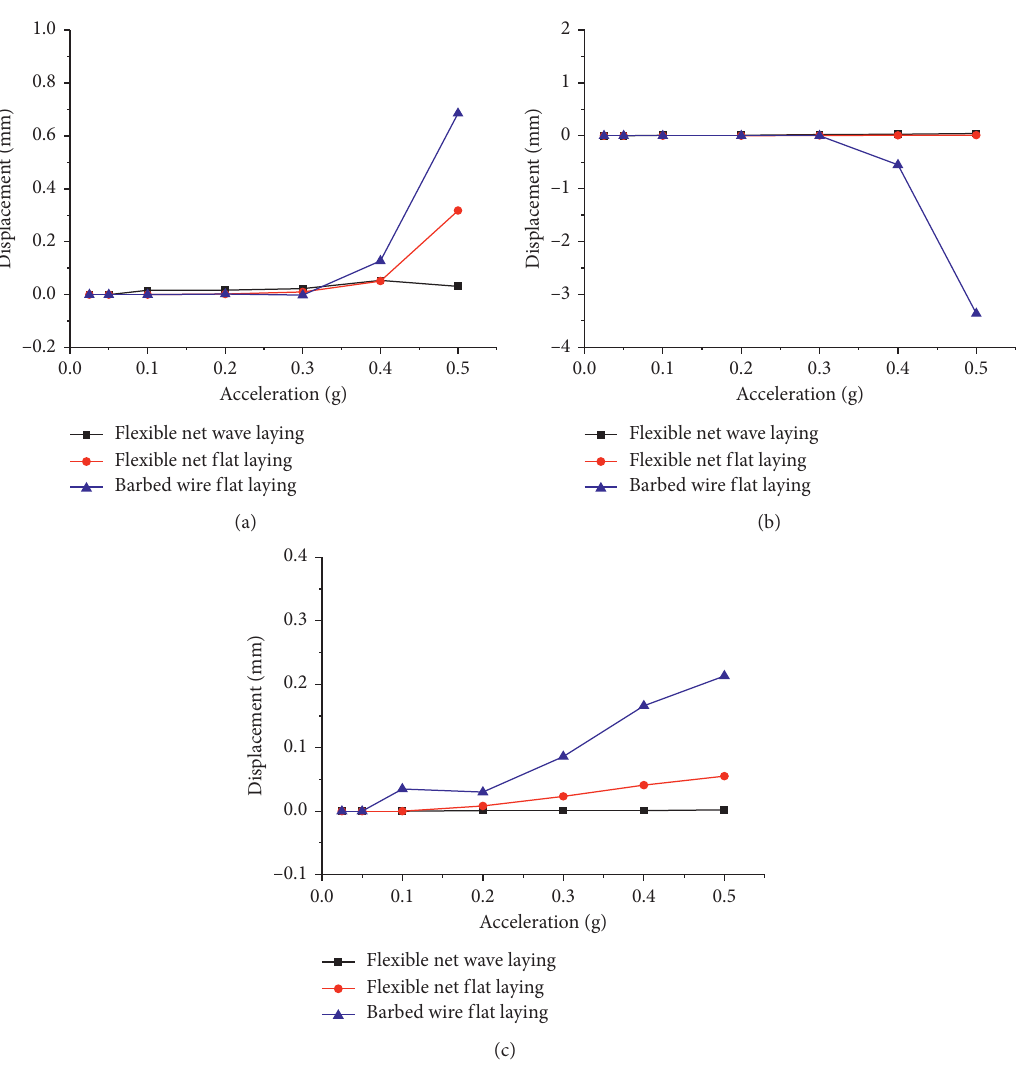
Figure 15: Substrate layer displacement at a slope of 80 ° . (a) H � 1.3 m. (b) H � 0.8m. (c) H �